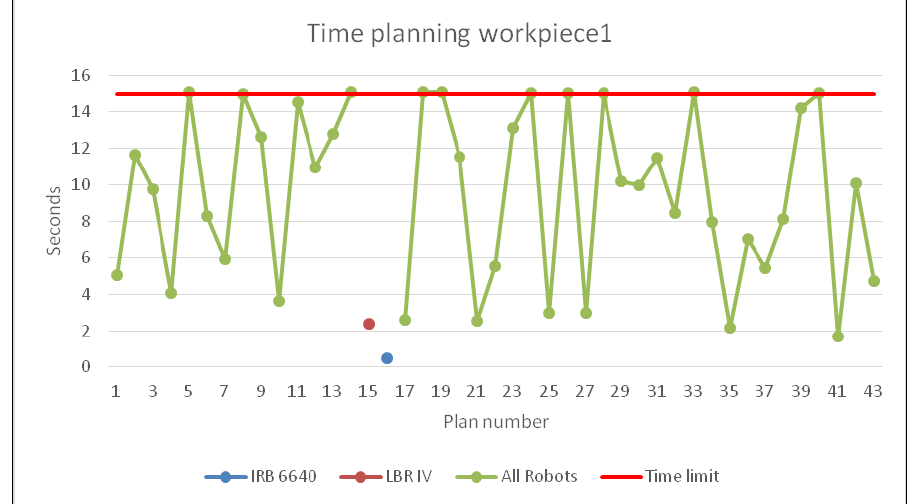
Figure 14. Times of planning cycles with “BKPIECE” to weld <piece 1>.